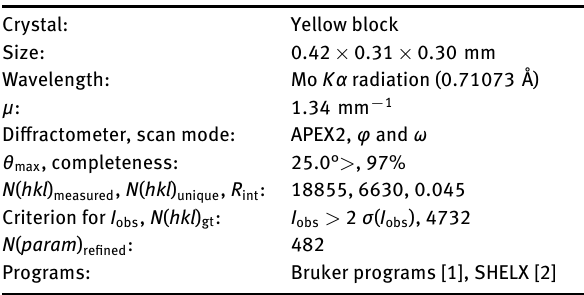
Table 1: Data collection and